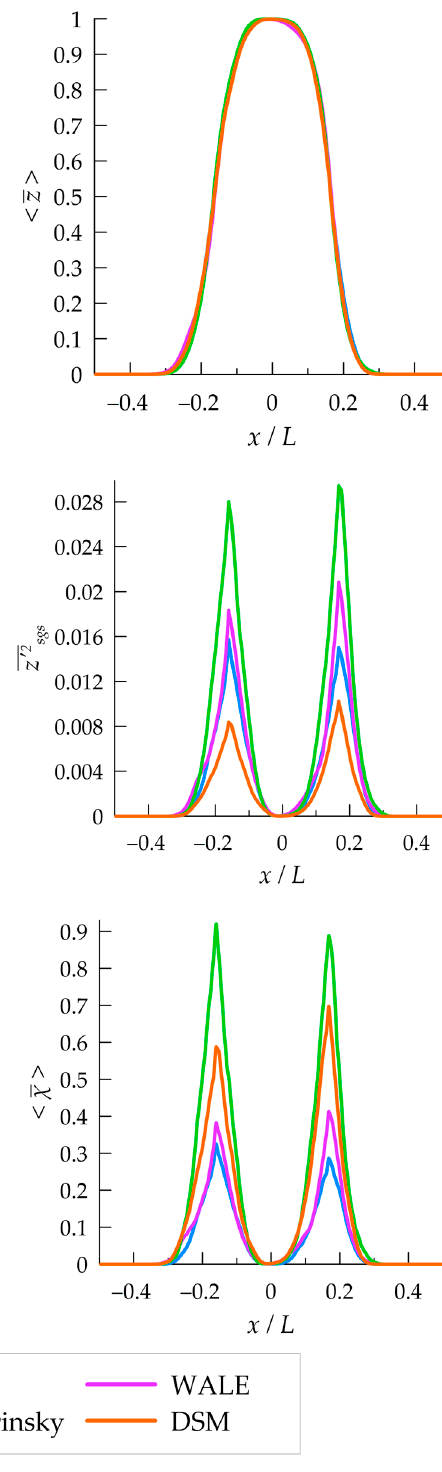
0 . Designations as in Figure